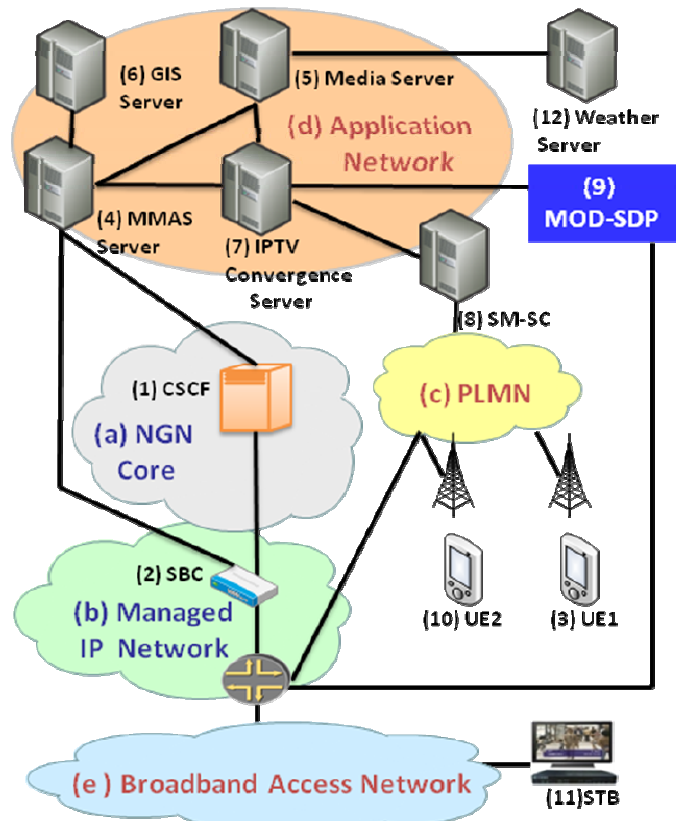
Figure 1. The NGN/IMS